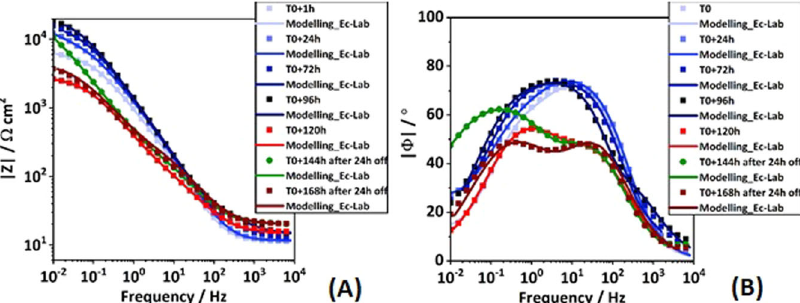
Fig. 13 Superposition of the experimental Bode diagrams and the Bode diagrams modelling with the EC-LAB ® software, obtained regularly during the 7 days of cathodic polarization with two interrupted phases (during the 5th and 7th days). The modulus in ( A ) and the phase in ( B ) are plotted in function of the frequency during 7 days of cathodic polarization with 2 days of interruptions (5th and 7th days) for an unpainted DH36 steel immersed in naturally aerated arti fi cial seawater, under static conditions at 20 °C.